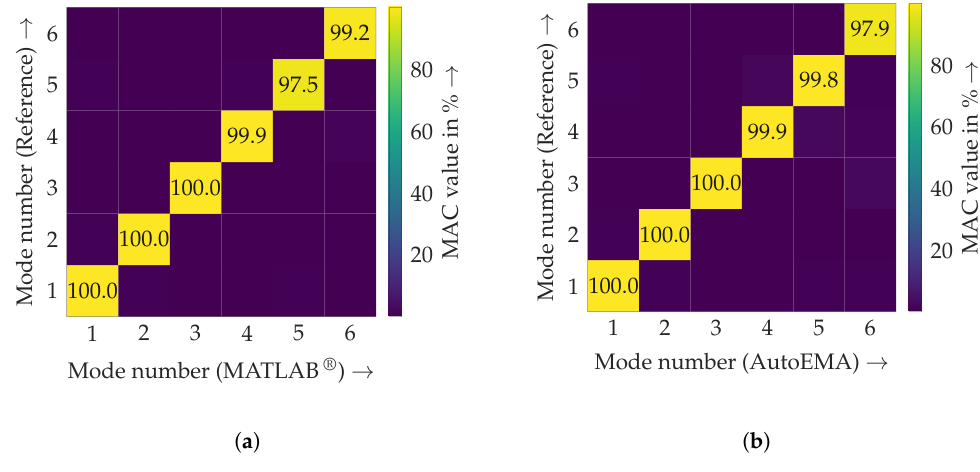
Figure 6. Comparison of the found mode shapes using the MAC; here, the mode shapes from solving the damped eigenvalue problem resulting from the MDOF oscillator in Section 3.1 were used as ground truth, ( a ) MATLAB ® modalfit , ( b ) AutoEMA.